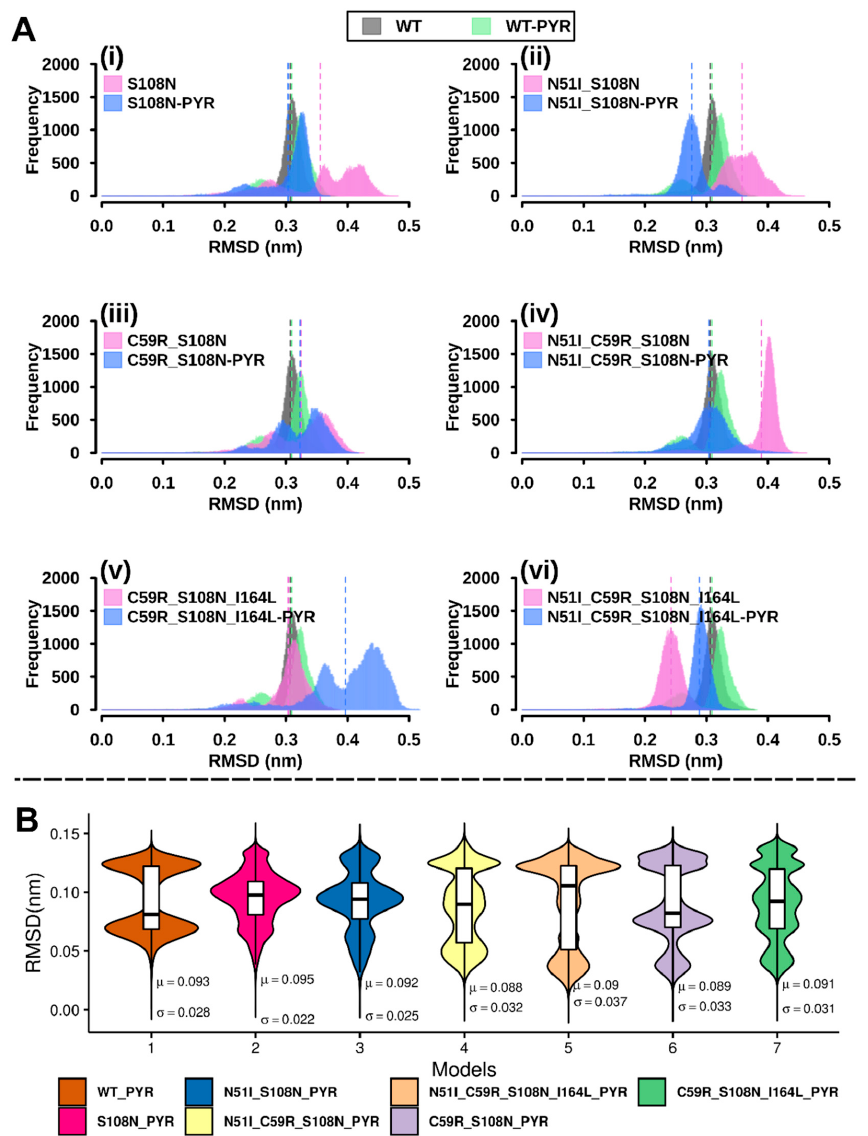
Figure 2. ( A ) Histograms showing protein root mean square deviation (RMSD) frequency distribution during 100-ns simulations: RMSD values were computed based on back-bone atom positions. The width corresponds to the number of conformations sampled by proteins over the molecular dynamics (MD) simulation. Y-axis (frequency) represents number of times a specific conformation was sampled during the MD simulation. ( i ) S108N, ( ii ) N51I_S108N, ( iii ) C59R_S108N, ( iv ) N51I_C59R_S108N, ( v ) C59R_S108N_I164L, and ( vi ) N51I_C59R_S108N_I164L. Color key: black WT—holo, green WT—pyrimethamine complex, magenta mutant—holo, and blue mutant—pyrimethamine complex. ( B ) Kernel density estimation graphs overlaid with boxplots showing the distribution of ligand RMSDs for each complex. Density traces were plotted symmetrically on each side: the width corresponds to the frequency of RMSD occurrence. Boxplots highlight the first, second (median), and third quartiles. The mean and standard deviation values are indicated by µ and σ, respectively.